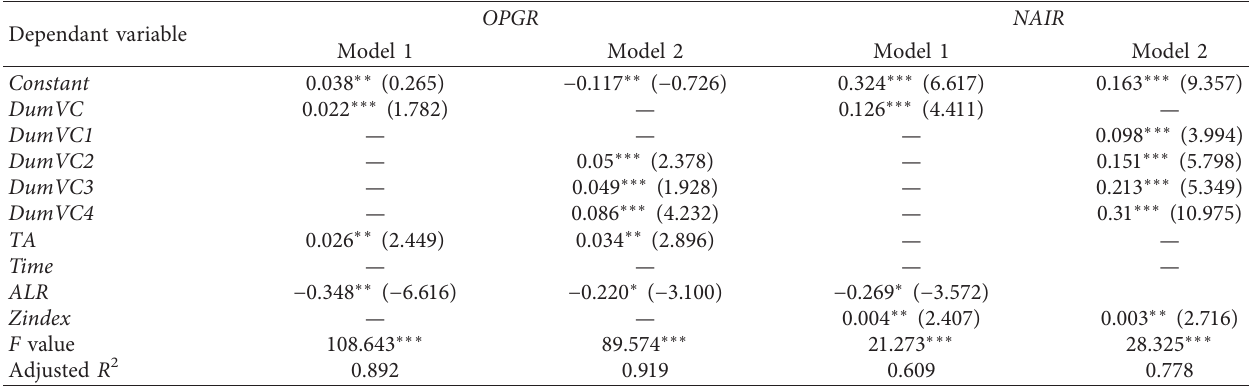
Table 3: Effects of venture capital on the profitability of